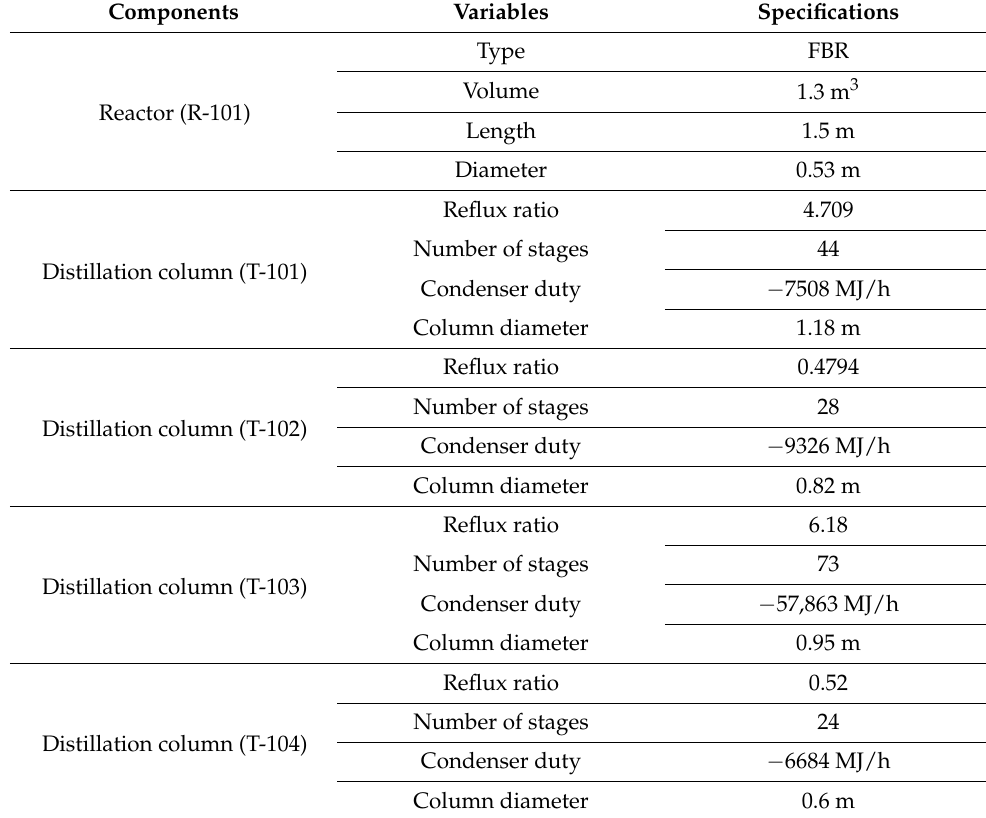
Table 4. Process main equipment design